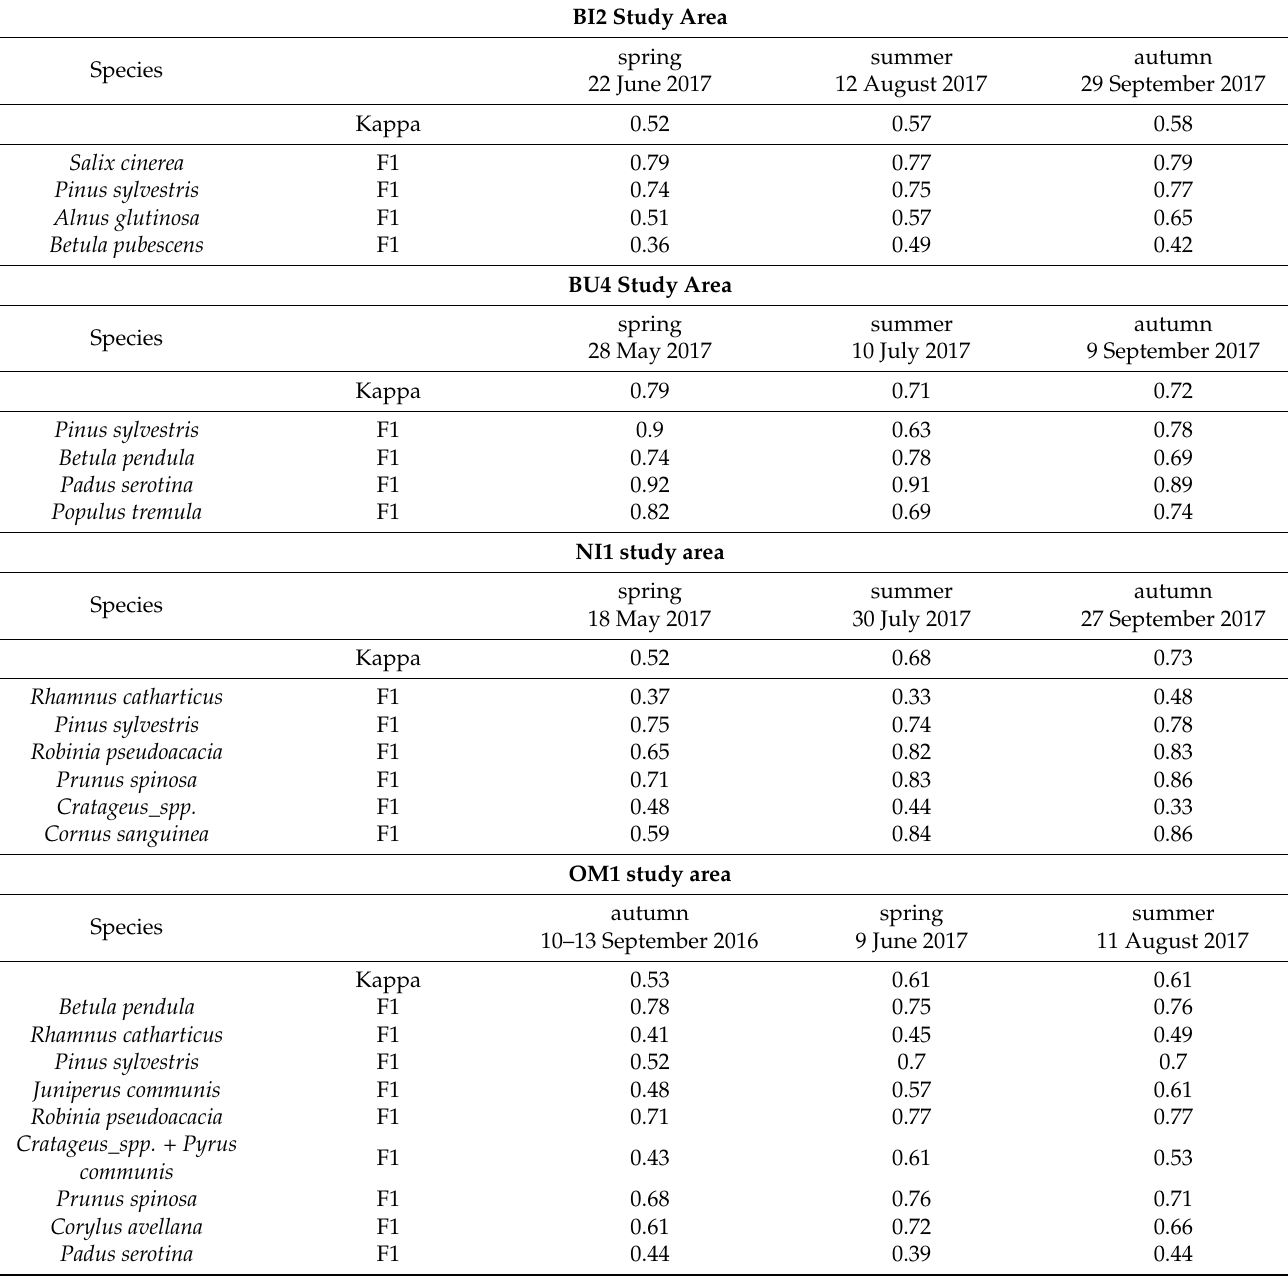
Table A4. The report of the influence the data acquisition date has on the accuracy of species